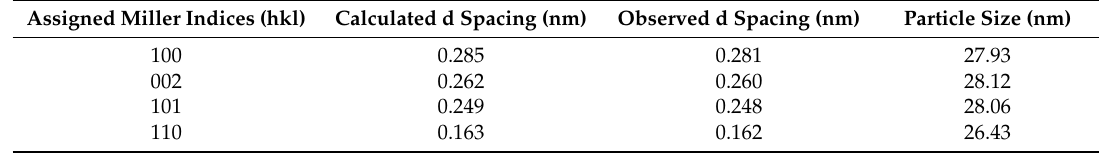
Table 1. Structural parameters of synthesized ZnO nanoparticles calculated from XRD spectra. Assigned Miller Indices